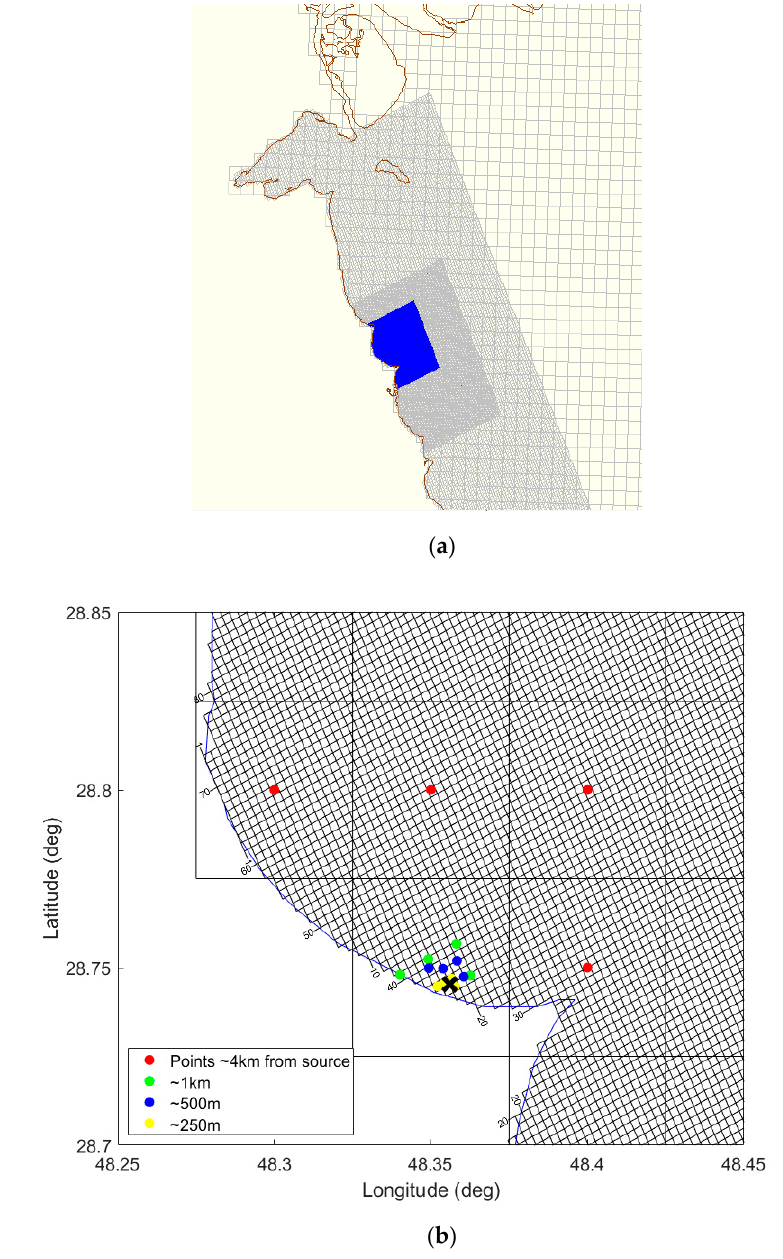
Figure 11. ( a ) Delft3D nested model, showing the four nesting levels used for this study: the outer model at 0.05-degree resolution, the mid-scale nested grid at 0.01-degree resolution, fine nested grid at 0.005-degree resolution, and finest nested grid at 0.0025-degree resolution; ( b ) observation points located at 0.25km to 4 km from source location (indicated by the